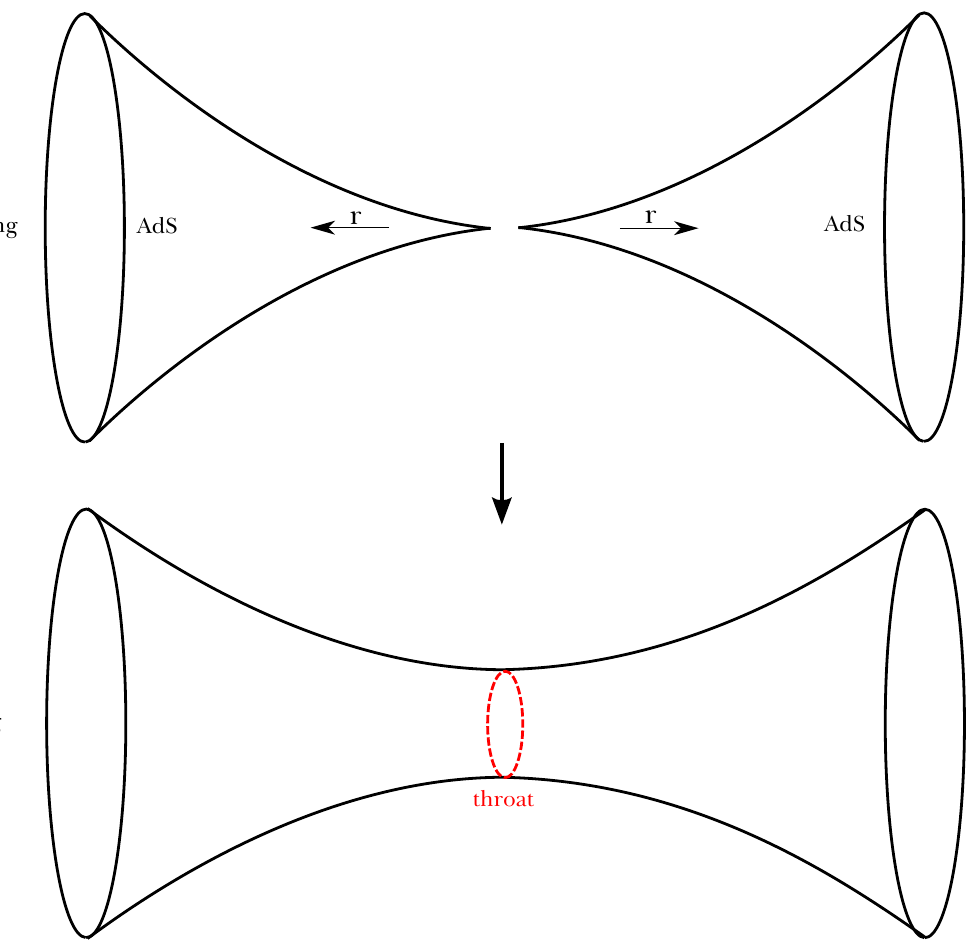
Figure 9. Conceptual picture of tunneling in anti-de Sitter space